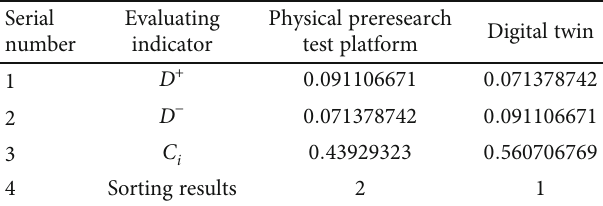
Table 6: C values and